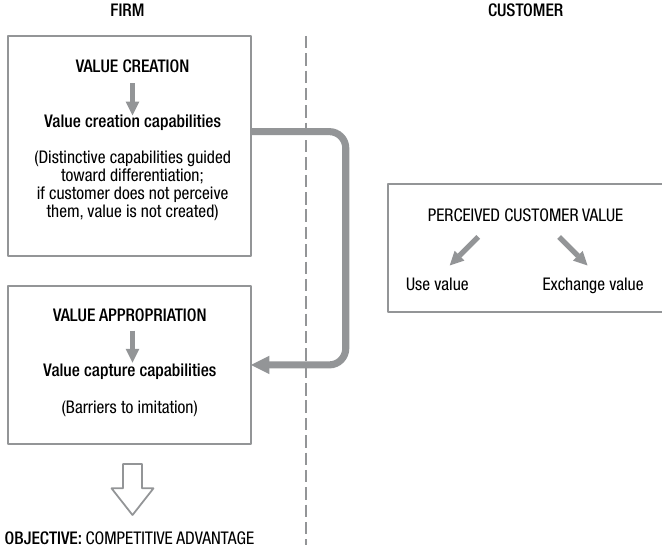
Fig. 3. An integrated view of customer value